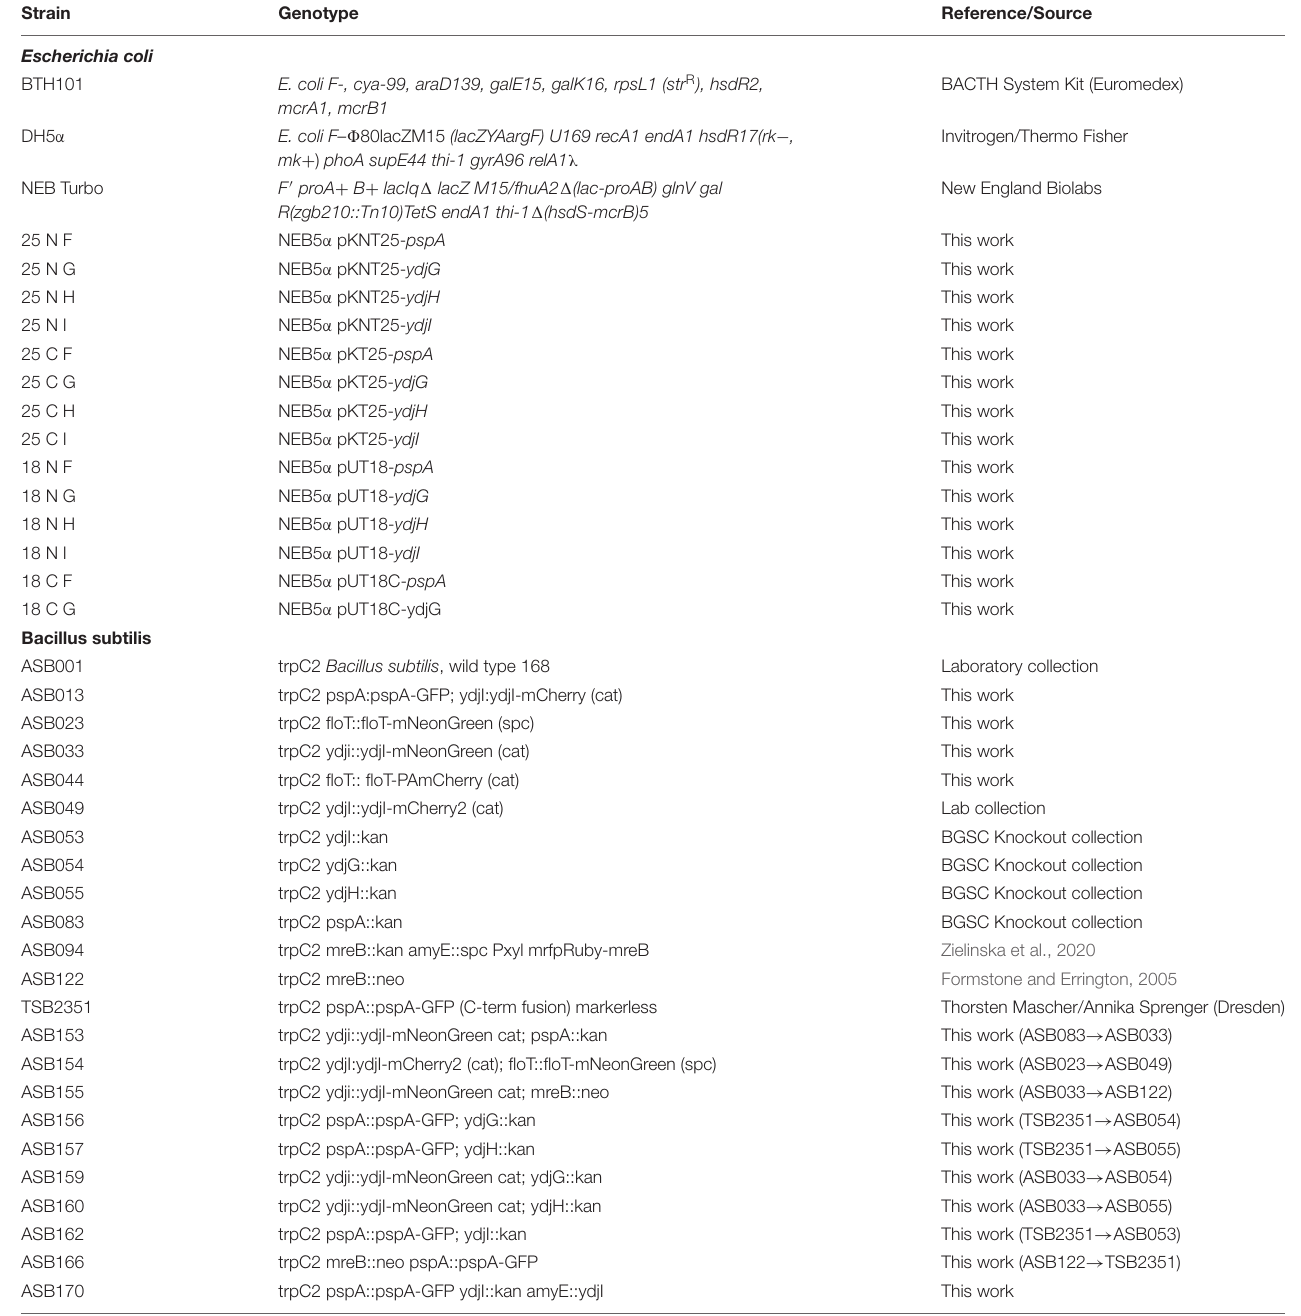
TABLE 2 | Strains used in this